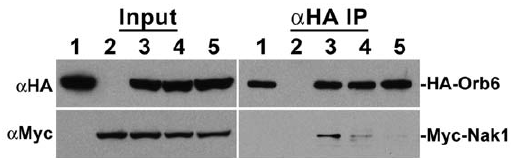
Figure 6. Orb6 phosphorylation site mutants impair interaction with Nak1. Extracts from WT (SP199) cells expressing HA-Orb6 and control vector (lane 1), Myc-Nak1 and control vector (lane 2), HA-Orb6 and Myc-Nak1 (lane 3), HA-Orb6 S291A and Myc-Nak1 (lane 4), or HA- Orb6 T456A and Myc-Nak1 (lane 5) from nmt1 promoter expression plasmids were analyzed by western-blots using anti-Myc (9E10) or anti- HA (12CA5) monoclonal antibodies (Input panels). HA-Orb6 was immunoprecipitated from cell extracts with anti-HA antibody and equal portions of the immunoprecipitates were probed with anti-HA antibody and anti-Myc antibody ( a HA IP